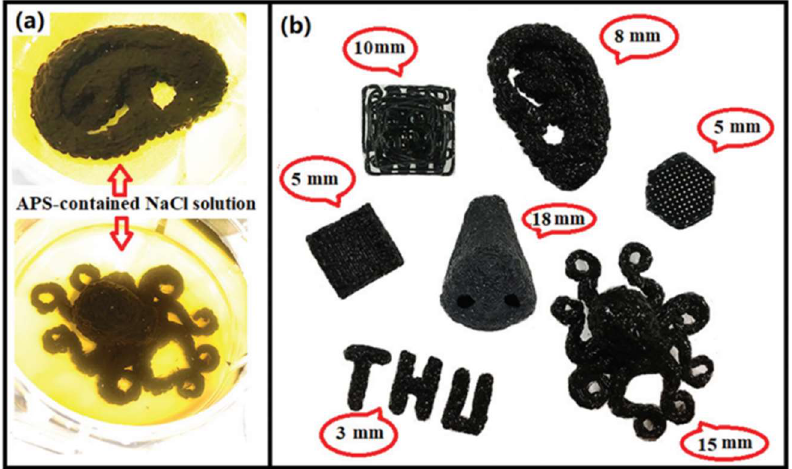
Figure 5. The geometries made by the 3D printing of the AAD-CS-Fe DN hydrogel containing 8 mg·mL −1 nano-Fe 3 O 4 . ( a ) A 3D model of the DN hydrogel in the pre-solution just after printing. ( b ) The 3D geometries made by the 3D printing. From left to right: Quadrangular pyramid, left ear, hexagonal prism, cuboid, nose, letters. The height of the corresponding models is shown in the red box. Adapted with permission from [30] . Copyright 2021, Wiley-VCH.